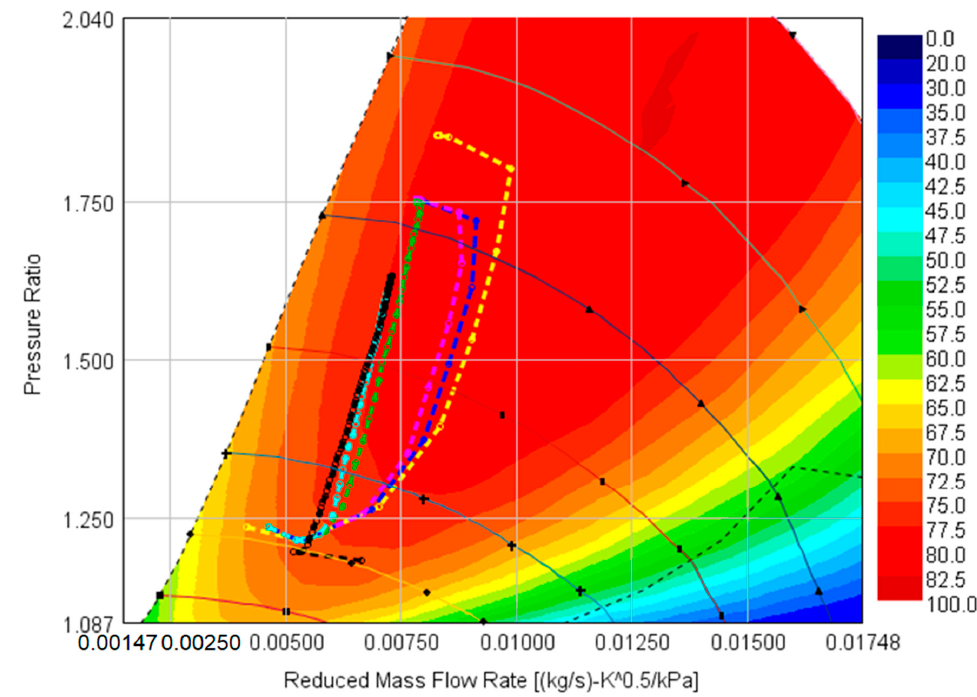
Figure 9. Compressor performance at 2000 rpm engine